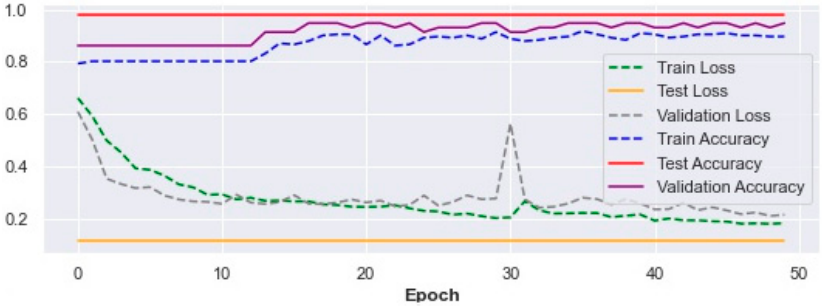
Figure 4. Train, test, and validation accuracy and loss results in the 5p-SAFE model.